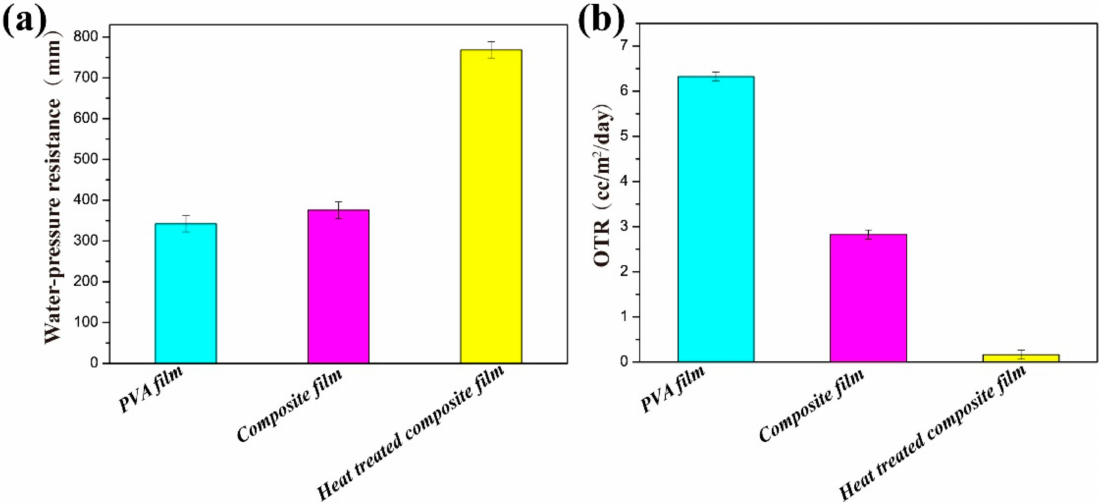
Figure 7. Water-resistant pressures ( a ) and OTRs ( b ) of the pure PVA film, PVA/ChWs composite film and heat treated PVA/ChWs composite film.